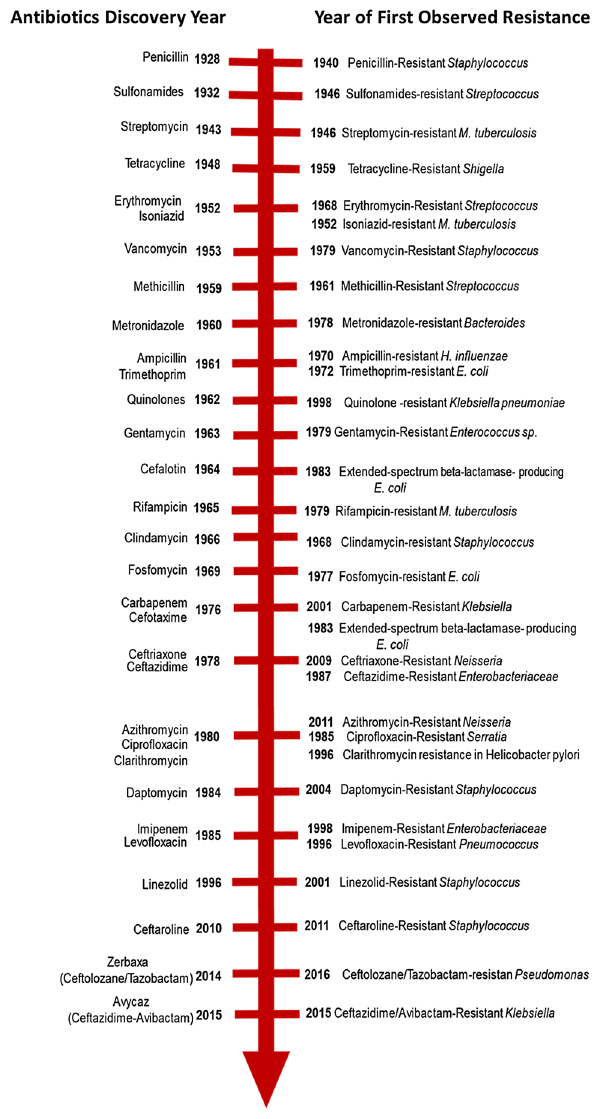
Fig. 1 Timeline of antibiotics discovery and year of first observed resistance